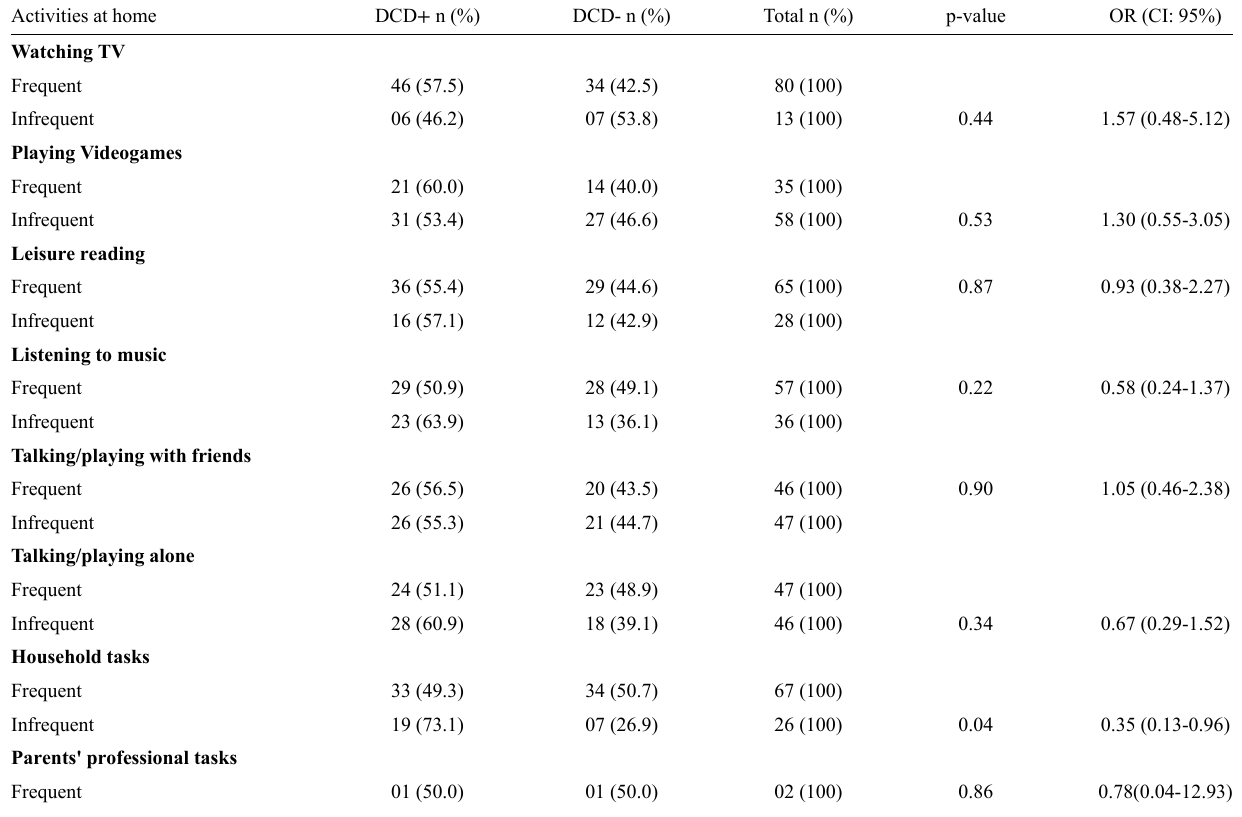
Table 1 - Analysis of the association between lifestyles through the activities performed at home and positive or negative DCD classification among stu- dents. Activities at